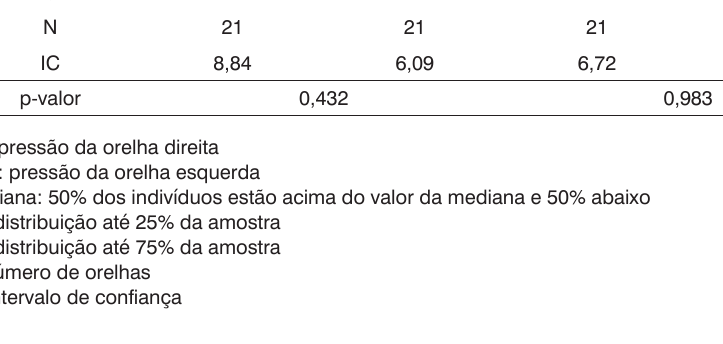
Tabela 4. Comparação dos lados da orelha para funcionamento da tuba auditiva intragrupo.